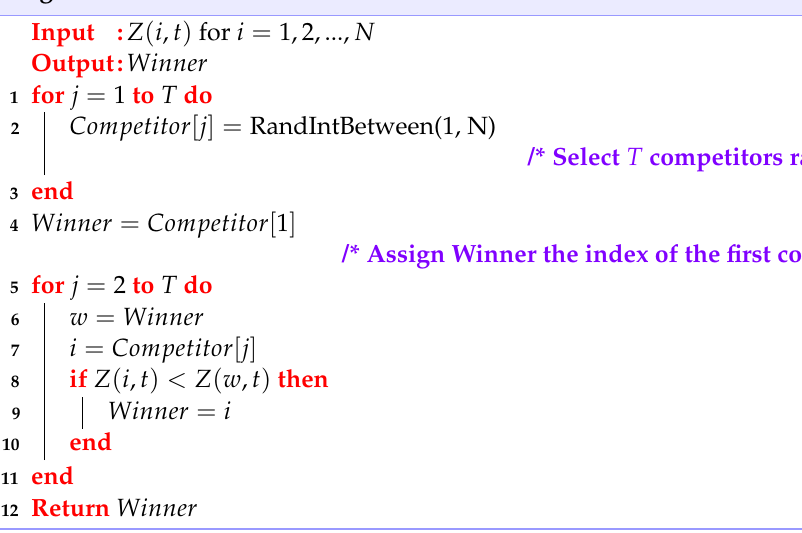
Algorithm 3: Monte Carlo Simulation of Tournament